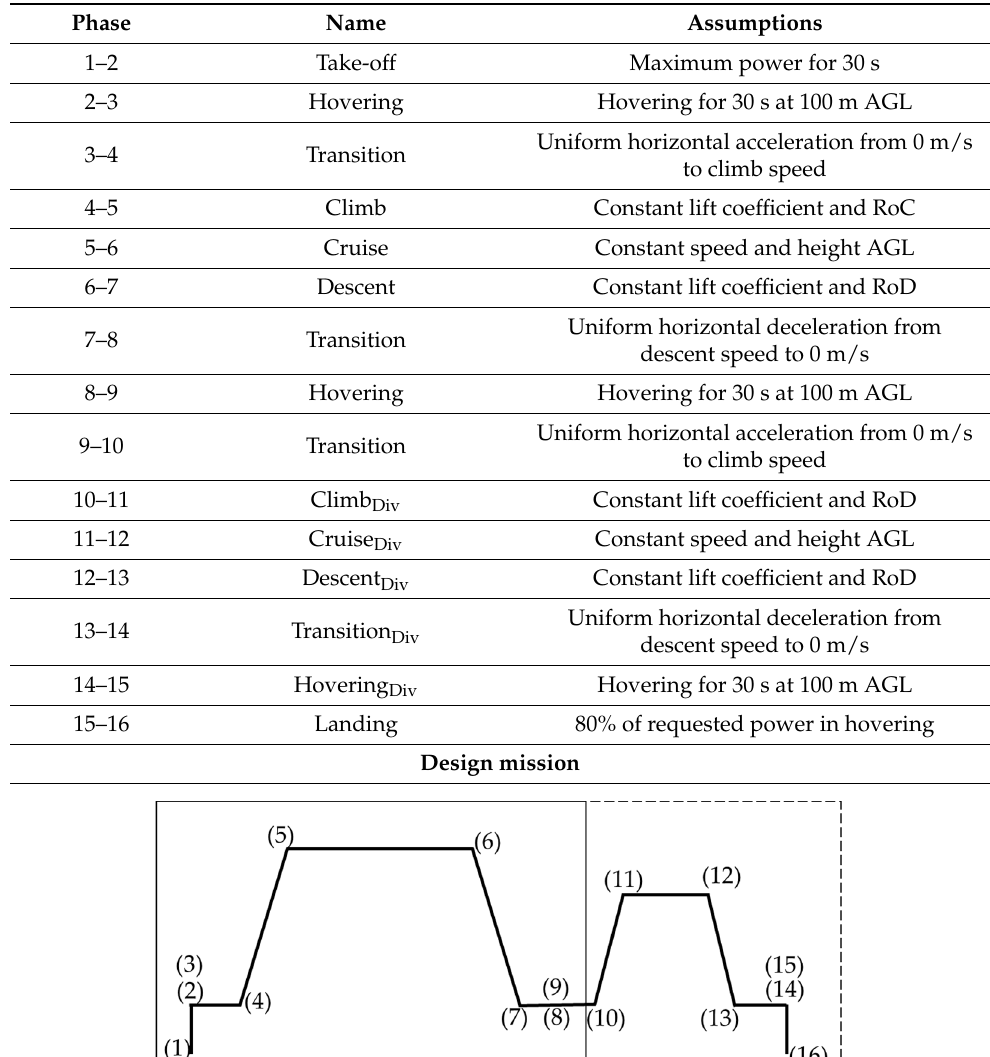
Table 4. Assumption for the design mission of the TiltOne